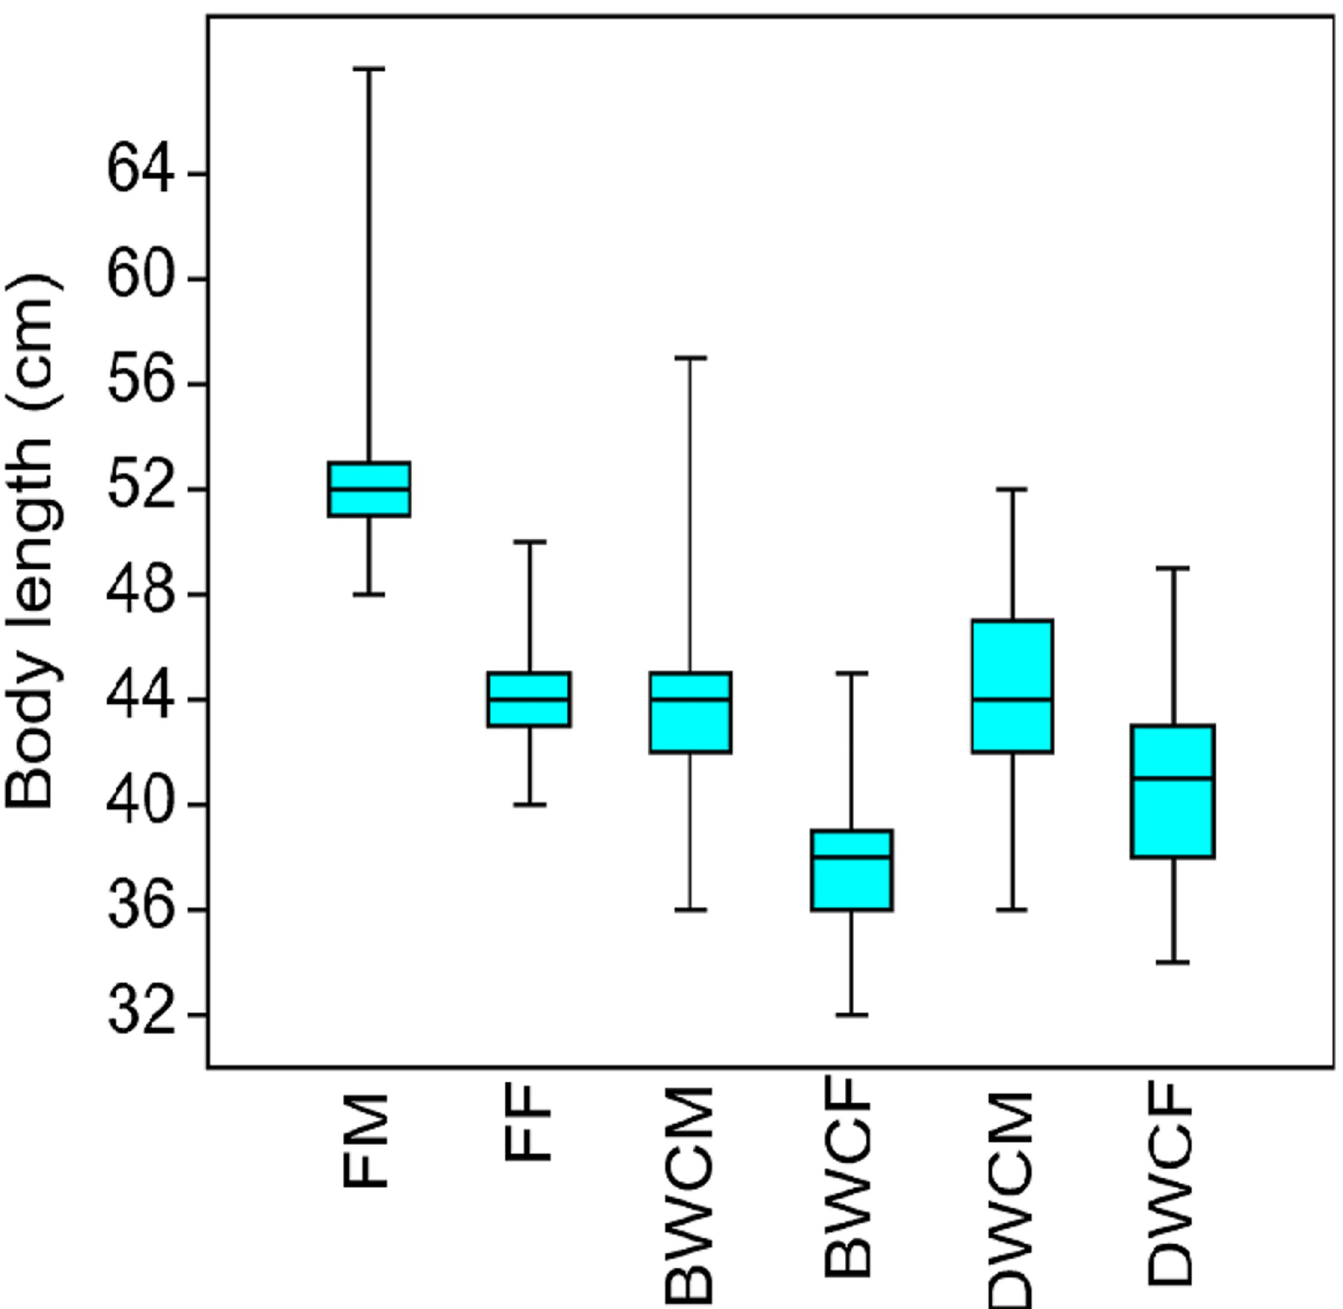
Fig 3. Box plot of the mink body length. Length excluding the tails of farm males (FM), farmed females (FF), Bornholm wild caught males (BWCM) and females (BWCF), from samples collected from 2014–2018. Denmark mainland wild caught males (DWCM) and females (DWCF). The rectangles represent the 95% confidence